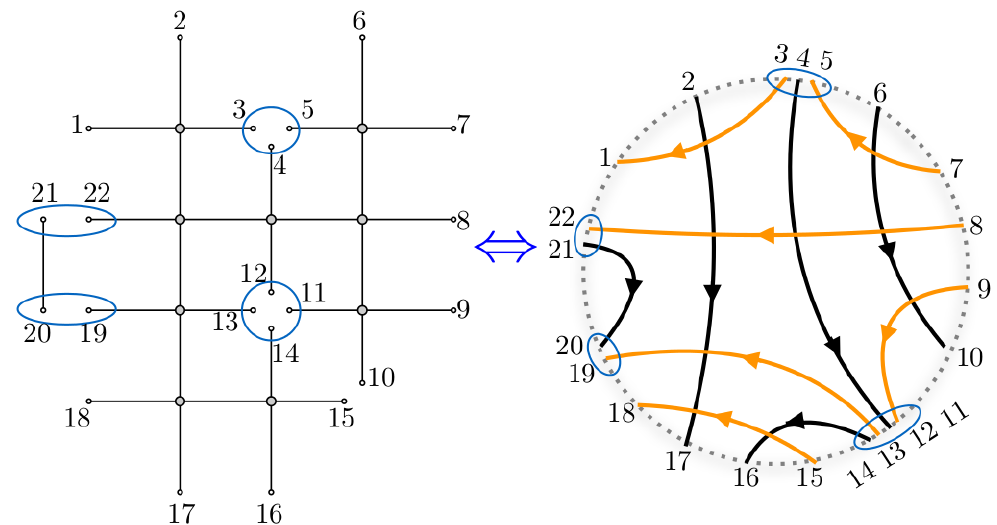
Figure 11 . To obtain a correlator diagram with irregular boundary we identify external points of a regular boundary (2 M = 22). This corresponds to identi(cid:12)cations of adjacent coordinates x 3 = x 4 = x 5 , x 11 = x 12 = x 13 = x 14 , x 19 = x 20 and x 21 = x 22 in the correlator K , cf. eq. (1.2). In the picture on the right-hand side, the (cid:13)avors of (cid:12)elds are explicitly indicated. We are allowed to identify coordinates of only those adjacent (cid:12)elds in K which are ordered as in the